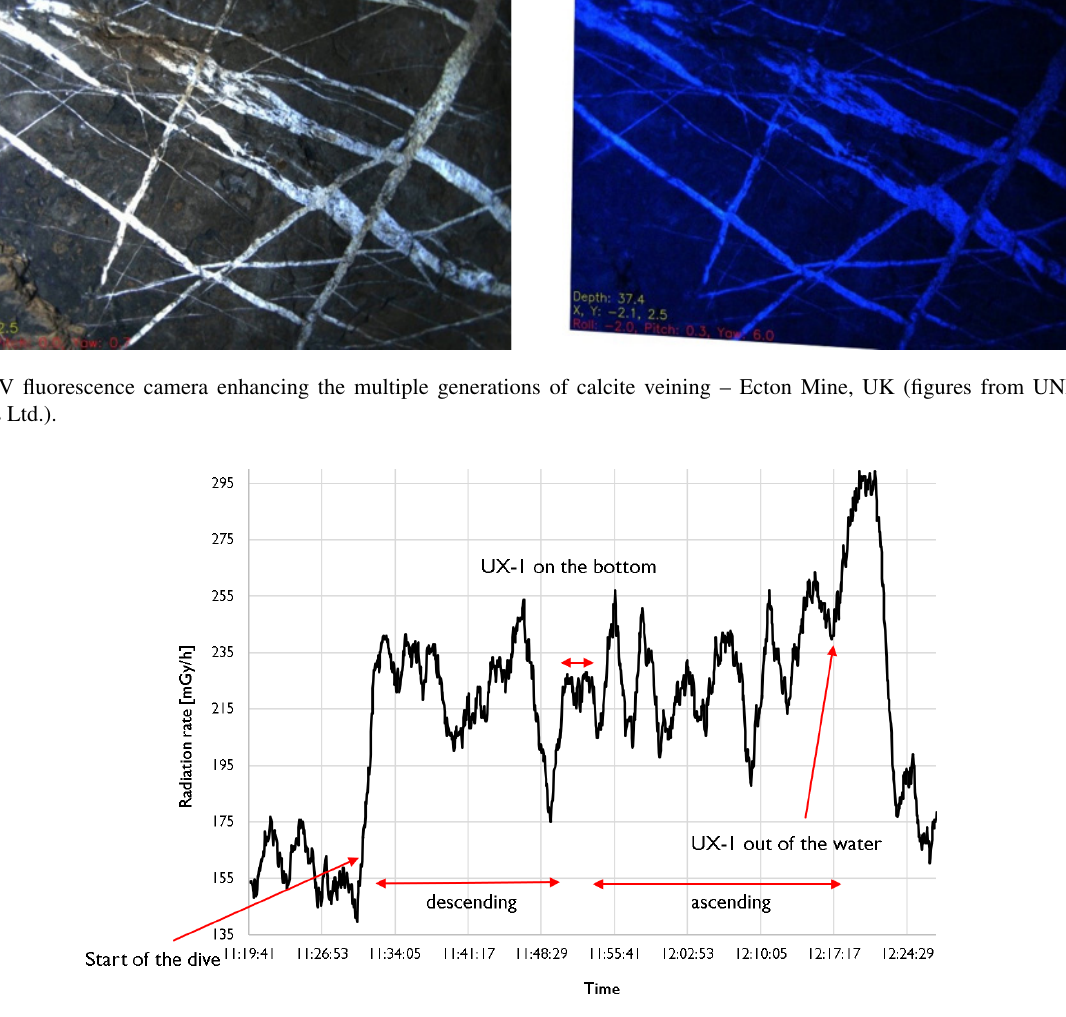
Figure 6. An example of the results obtained by the gamma-ray sensor. The robots’ internal navigation system also records their location and orientation, so 3D radiation maps can be produced in the future. Data were collected during a dive in Urgeiriça uranium mine, Portugal (Žibret,